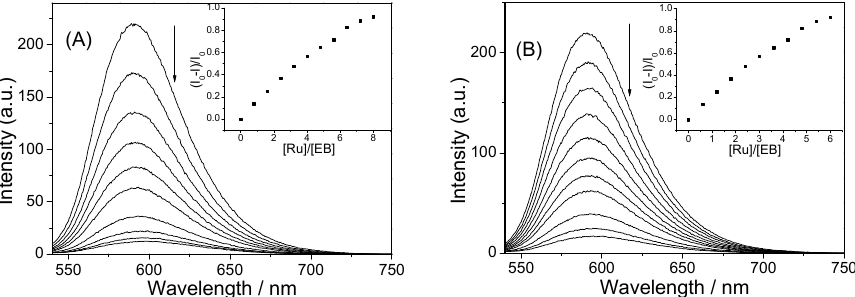
Figure 5. Luminescence spectra of EB-DNA system after adding ruthenium complexes. ( A ) 1 and ( B ) 2 .